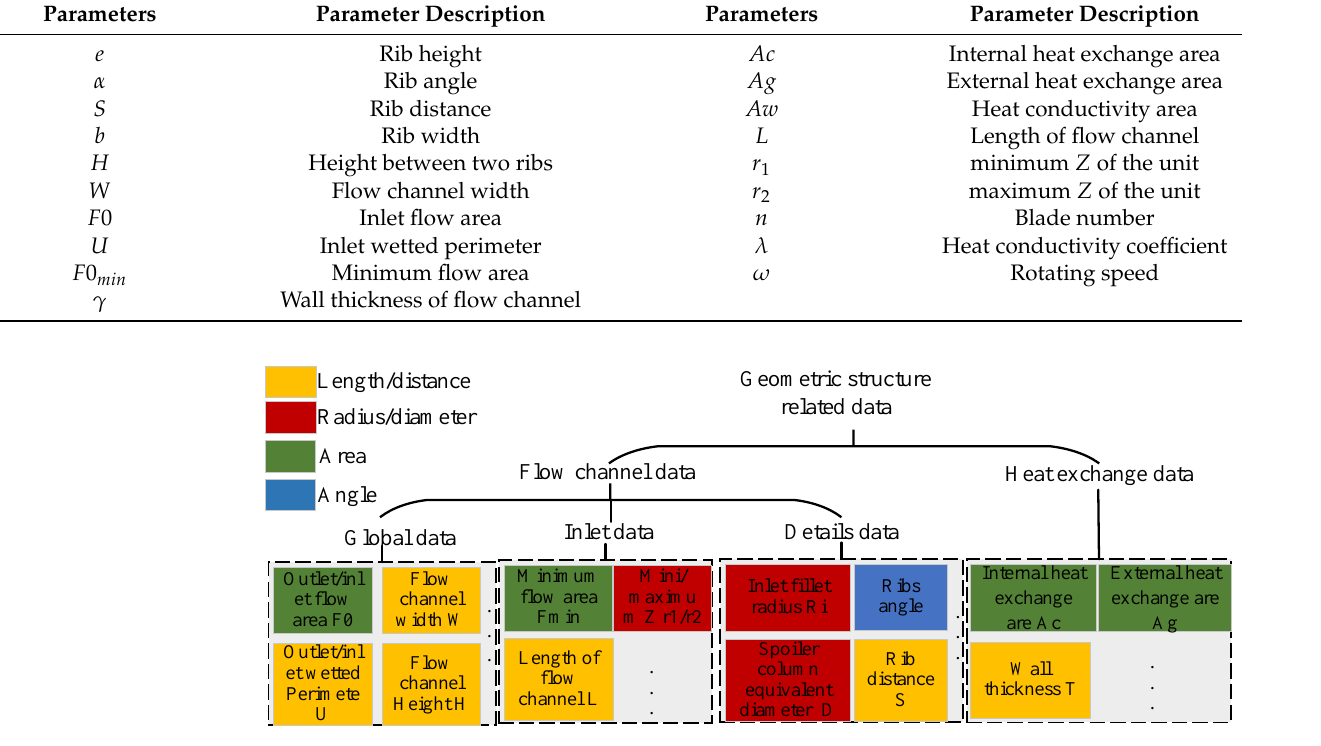
Figure 27. Classification of analysis data required for pipe-network